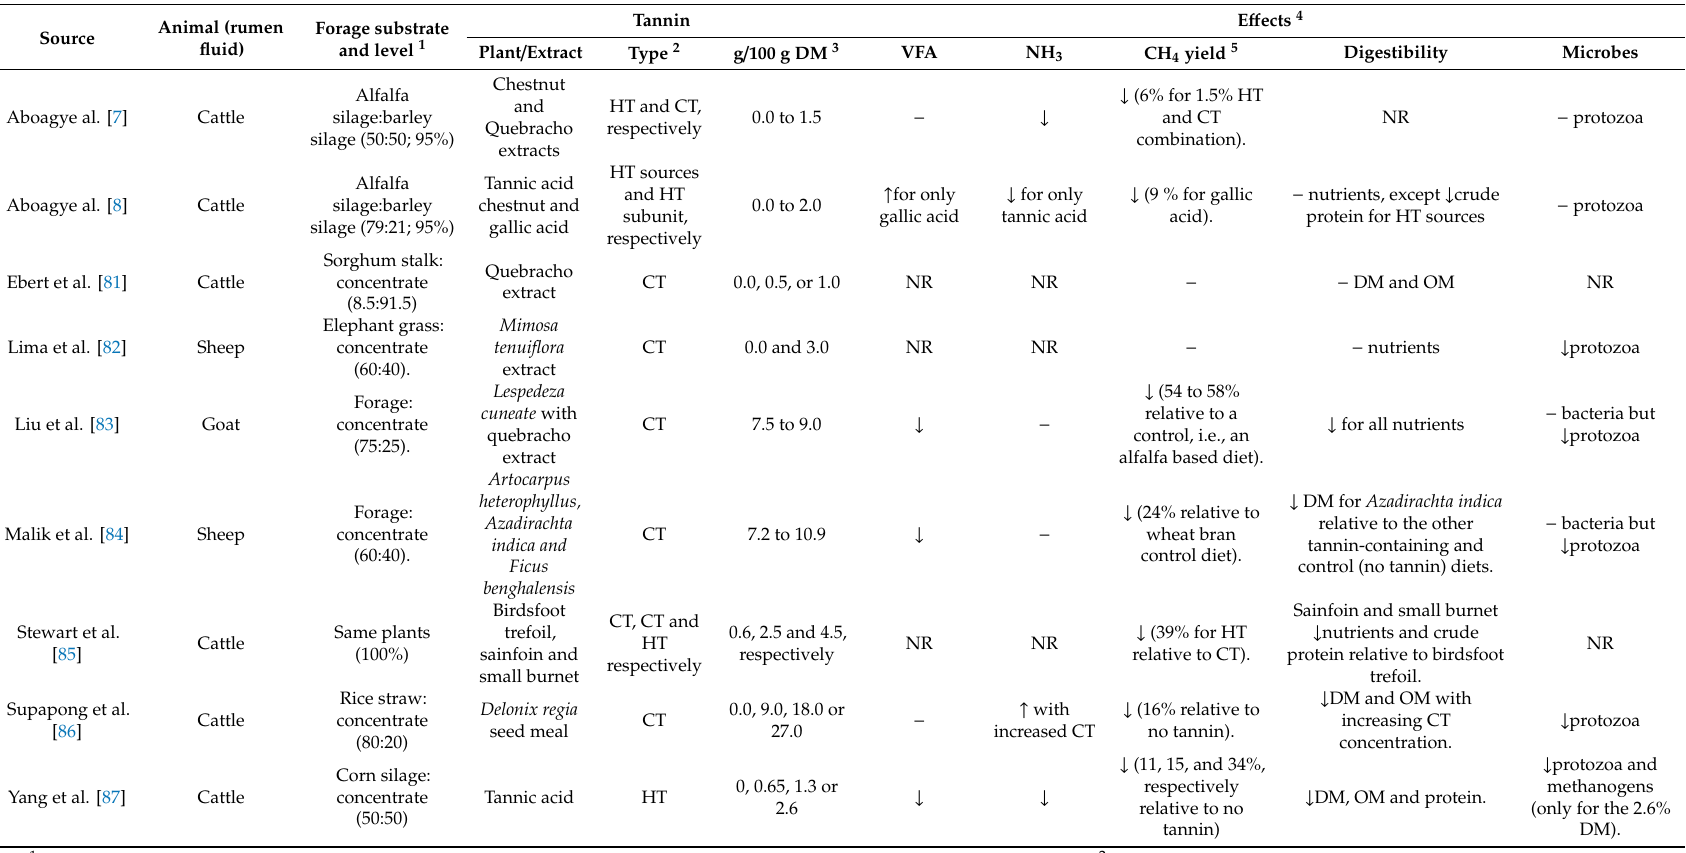
Table 4. Summary of tannin e ff ects on in vivo fermentation, digestibility, microbes and enteric methane production in